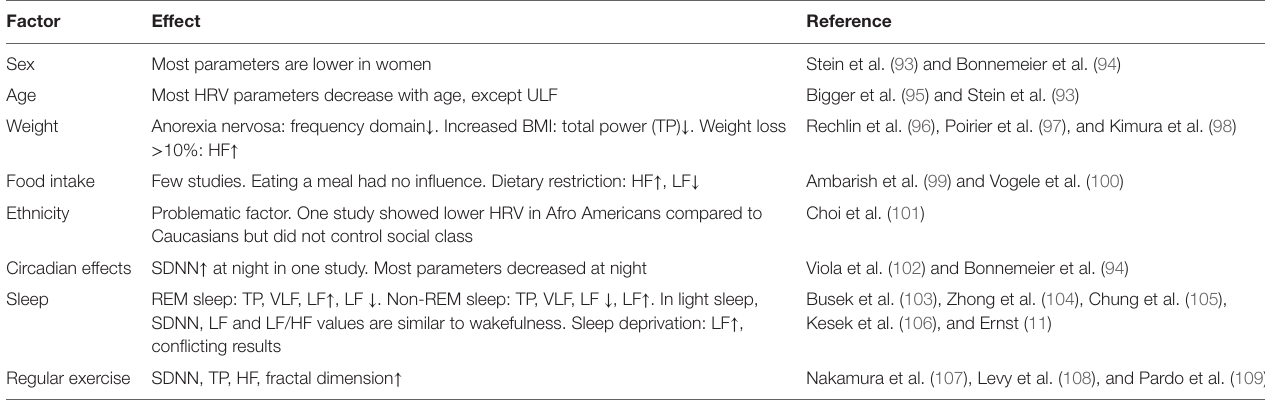
Table 2 | Physiological factors on heart rate variability